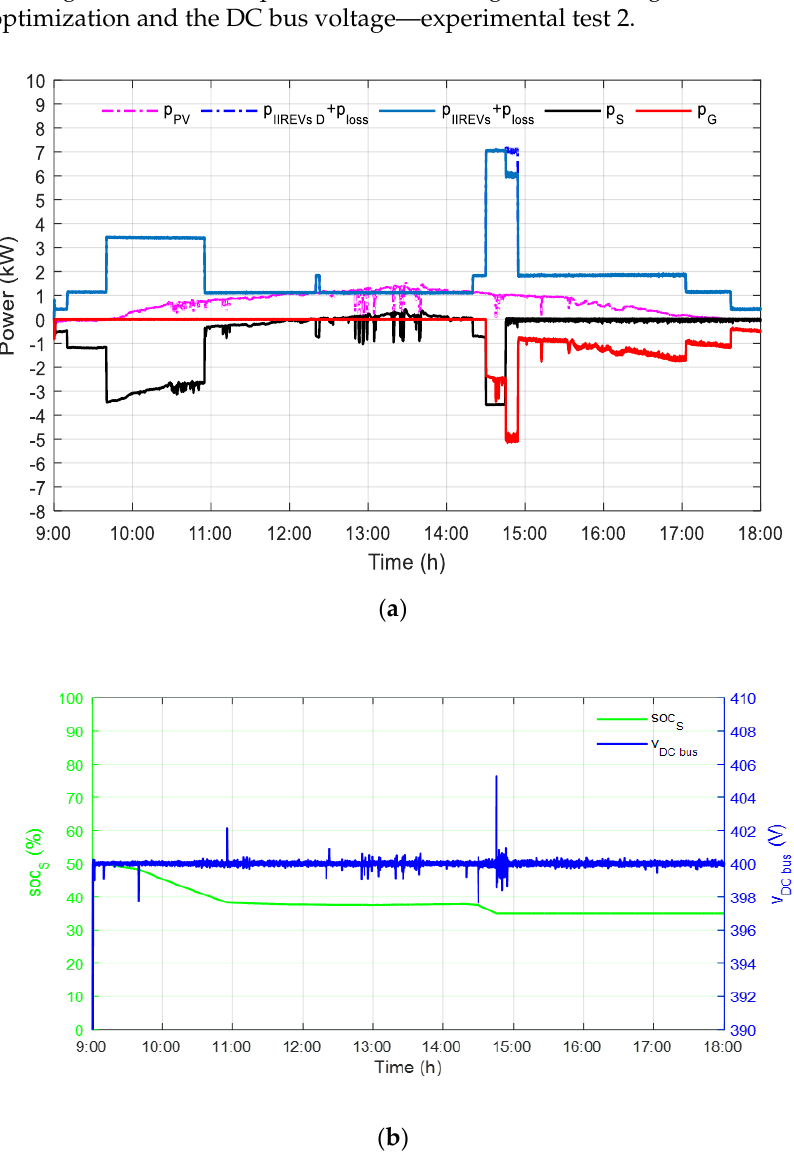
Figure 24. Power flow and storage state of charge for “real - time exp” w ithout optimization ( a ) and ( b ) storage state of charge and DC bus voltage — experimental test 2.